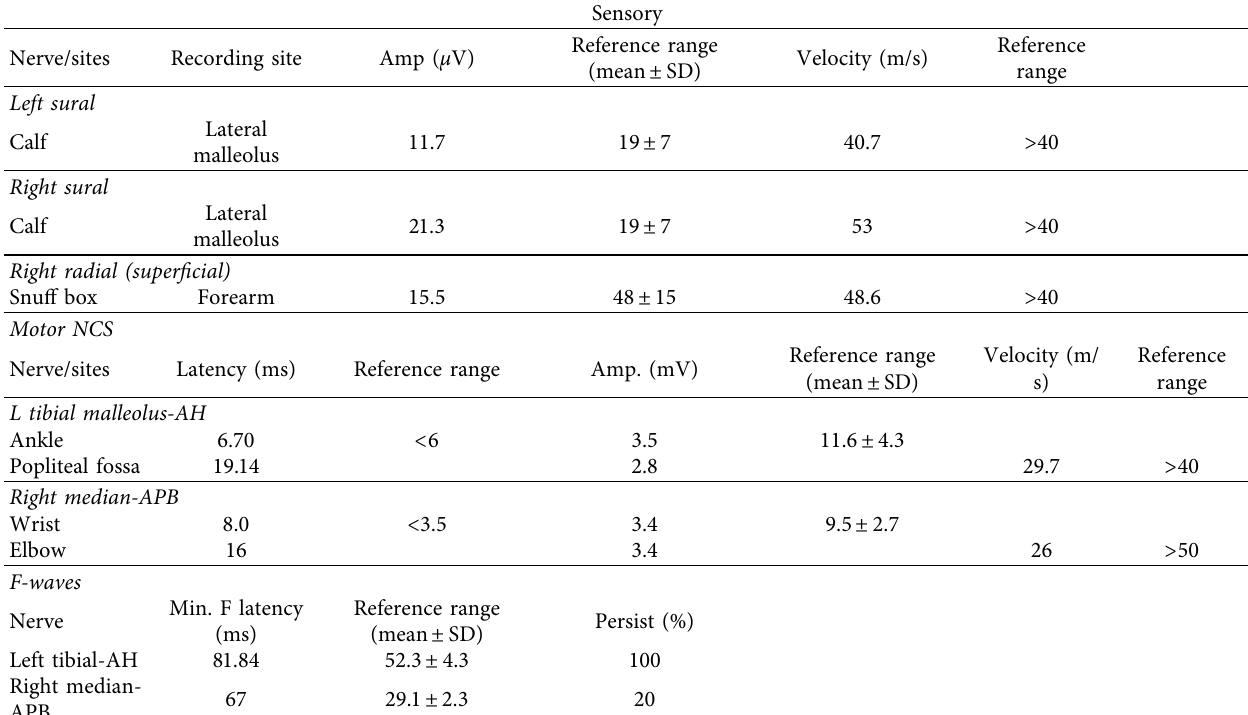
Table 1: Nerve conduction study findings in our patient.